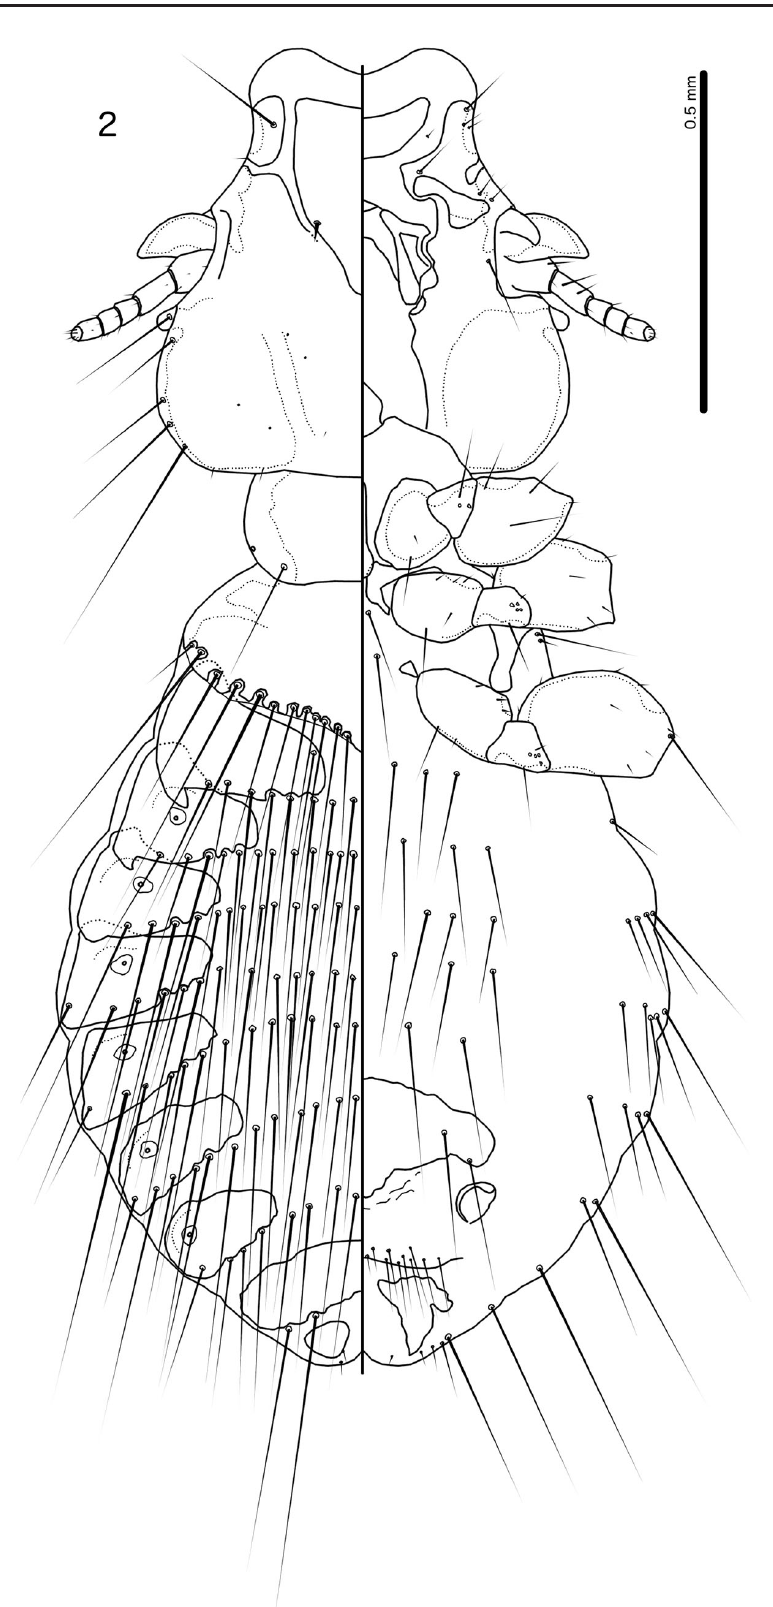
Fig. 2. Philopterus hebes sp. nov. ex Chloropsis aurifrons inornata Kloss, 1918, female habitus, dorsal and ventral